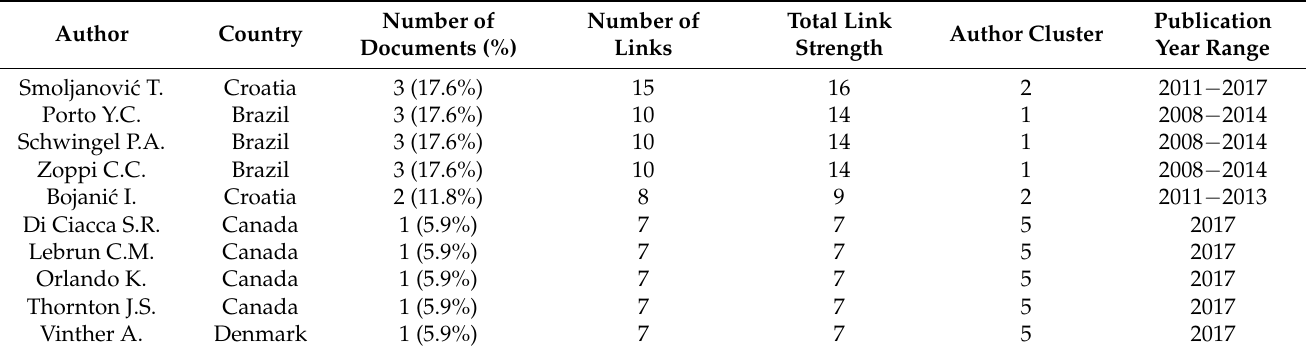
Table 5. The ten most productive authors on para-rowing.